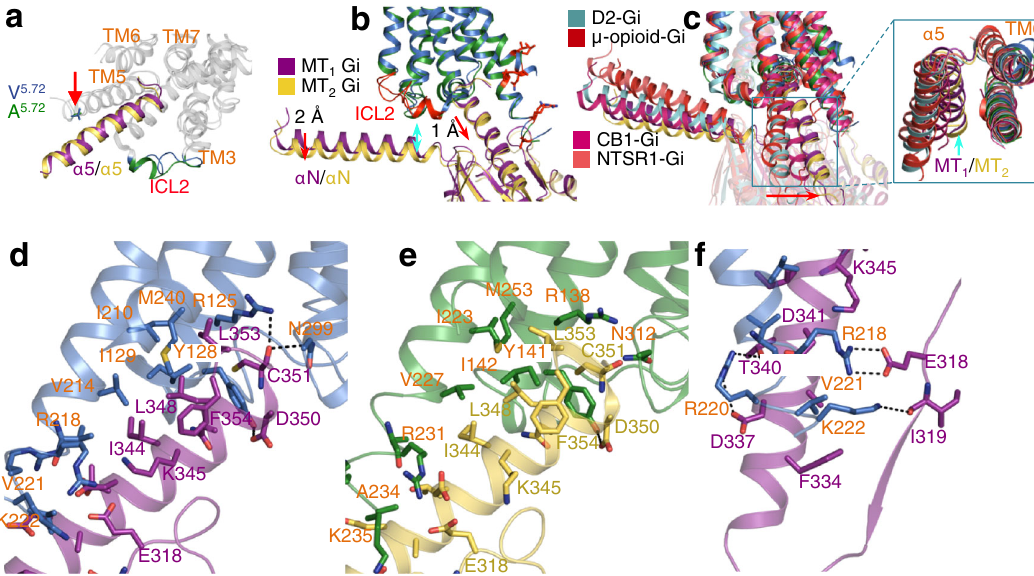
Fig. 4 The G i conformations and interfaces in MT 1 -G i and MT 2 -G i complexes. a Comparison of the receptor core (gray) engaging the α 5 helix in MT 1 -G i (purple) and MT 2 -G i (yellow) complexes. The indicated (red arrow) residue 5.72 is the only different residue (V 5.72 in MT 1 and A 5.72 in MT 2 ). b The conformations of the G i bound to MT 1 and MT 2 . Displacements of α N and α 5 are highlighted with red arrows. α N is located far from ICL2, indicated by the cyan arrow. c The orientations of the α 5 helices in MT 1 , MT 2 , and other G i -coupled receptors. d, e α 5 helix-mediated interactions in MT 1 -G i ( d ) and MT 2 -G i ( e ) complexes. f The polar interactions in the MT 1 -G i interface. Hydrogen bonds are highlighted with